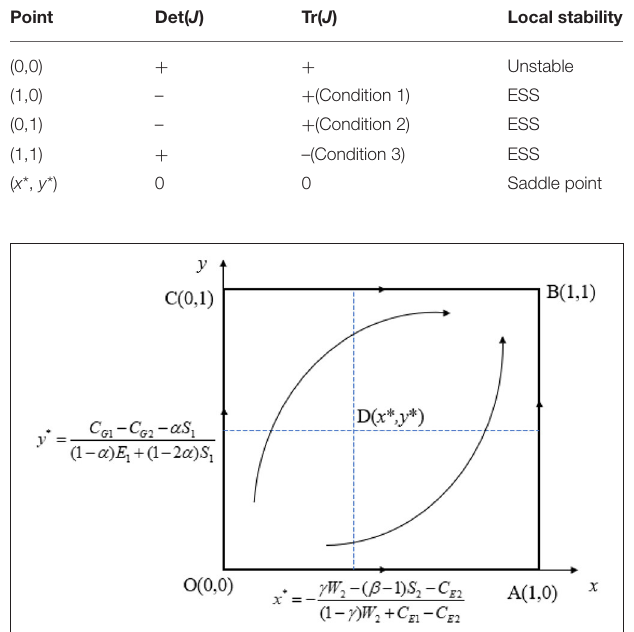
FIGURE 5 | System replication dynamic phase diagram.